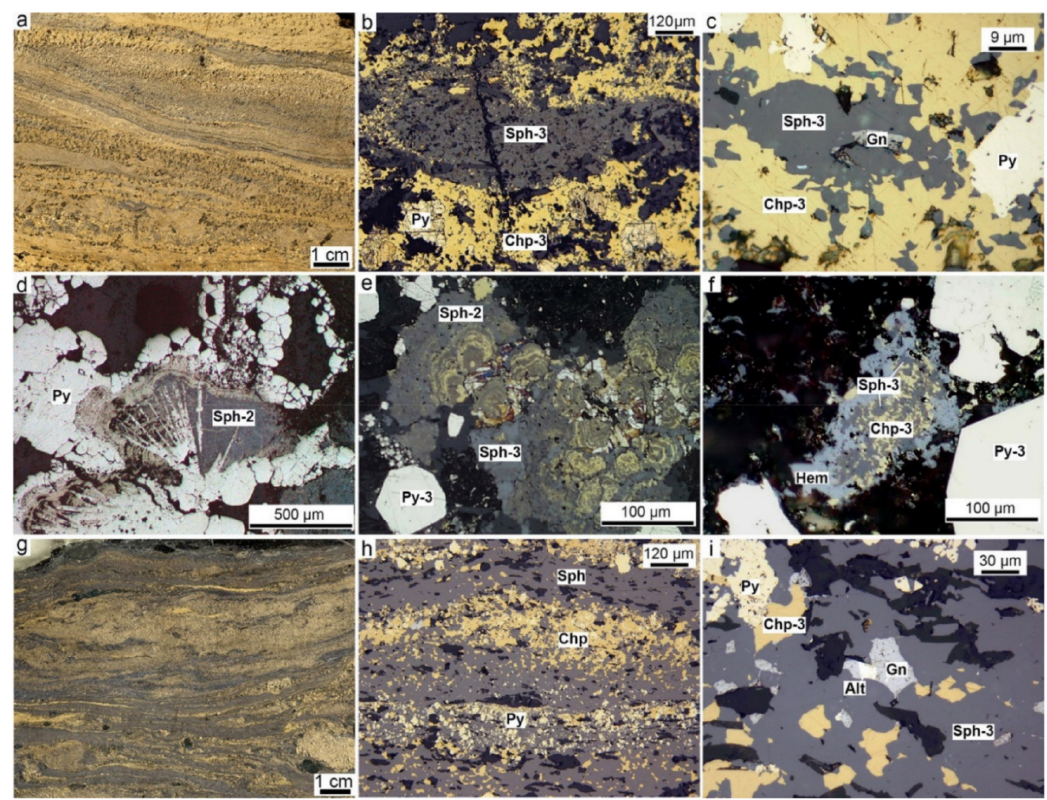
Figure 12. Mineral features of sphalerite-rich diagenites of the Yubileynoe ( a – c ), Yaman-Kasy ( d – f ), and Molodezhnoe ( g – i ) deposits: ( a ) Alternating sphalerite- and chalcopyrite-rich diagenites; ( b ) porous sphalerite-rich layer; ( c ) galena inclusion in sphalerite-3; ( d ) replacement of radial pyrite by sphalerite-2; ( e ) replacement of chalcopyrite–sphalerite clast by sphalerite-2 and sphalerite-3; ( f ) successive replacement of chalcopyrite-3 by sphalerite-3 and hematite in assemblage with euhedral pyrite-3 in hematite–quartz aggregates; ( g ) sphalerite-rich diagenites intercalated with pyrite- and chalcopyrite-rich diagenites; ( h ) intercalation of sphalerite- and chalcopyrite-rich diagenites; ( i ) galena and altaite inclusions in sphalerite-rich diagenite. ( a , g ) Polished sample, ( b – f , h – i ) reflected